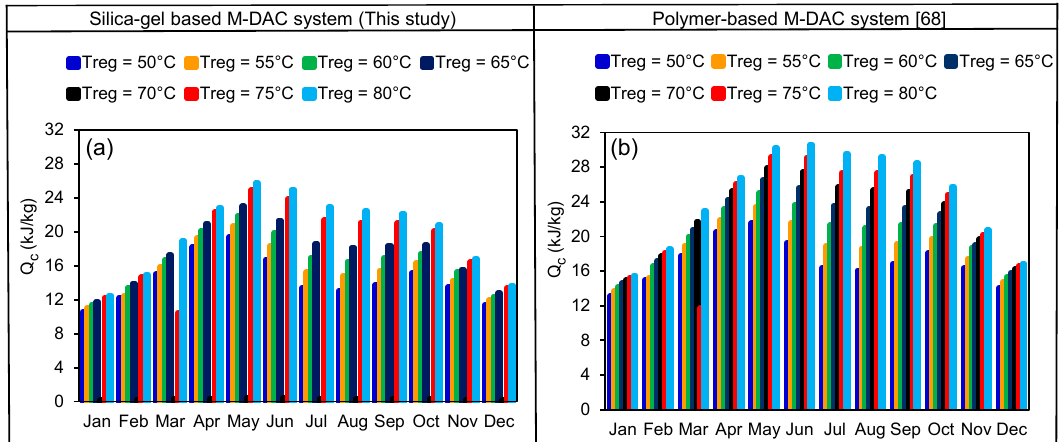
Figure A2. The cooling capacity of ( a ) silica-gel-based M-DAC system and ( b ) polymer-based M-DAC system at different regeneration temperatures.